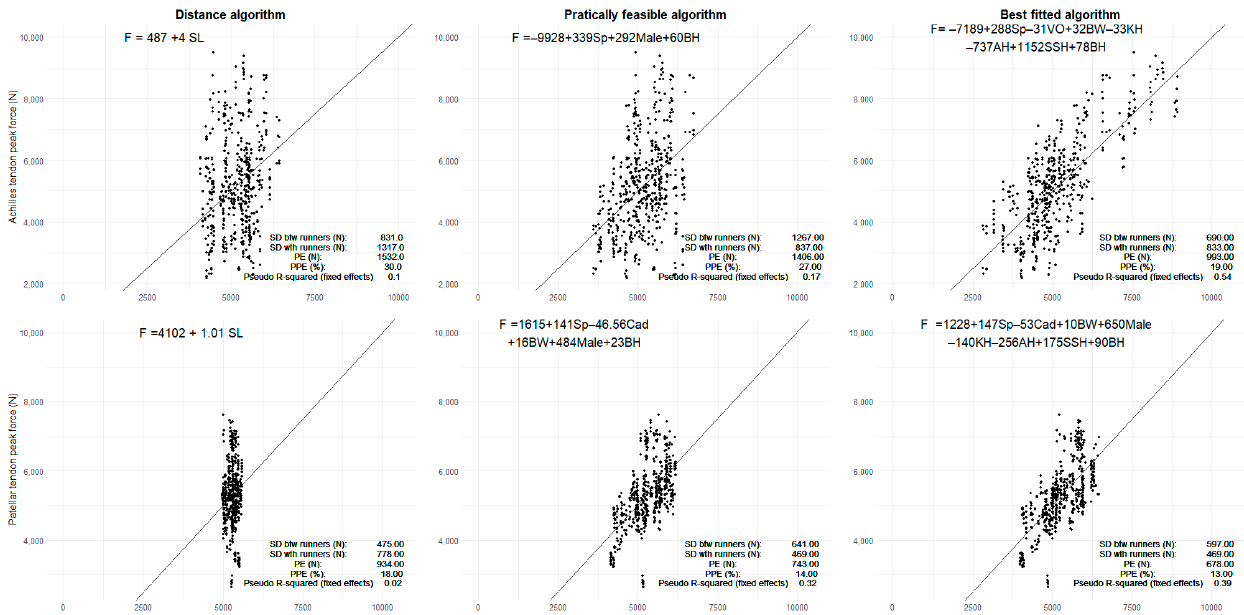
Figure 3. The prediction of peak forces using the different algorithms. The black diagonal line is the perfectly fitted line. The black dots are the AnyBody-estimated force on the y -axis and predicted forces on the x -axis. SL: Stride length; Sp: Speed; BH: Body height; BW: Bodyweight; KH: Knee height; AH: Ankle height; SSH: Shoe sole height; Cad: Cadence.